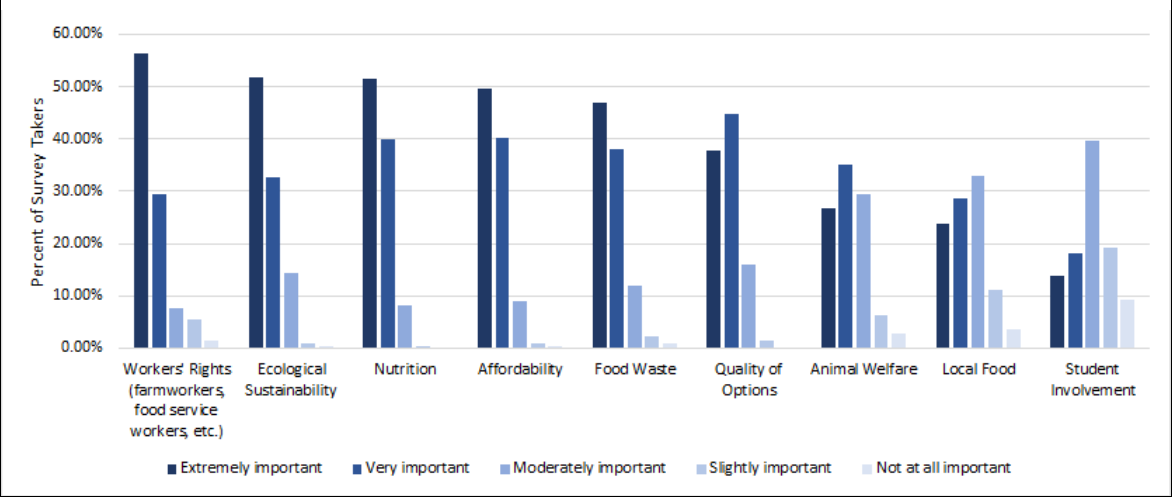
Figure 4. Ranking of Students’ Values Students were asked to rank the nine categories by level of importance. Most often, students ranked worker’s rights, ecological sustainability, nutrition, affordability, and food waste as extremely